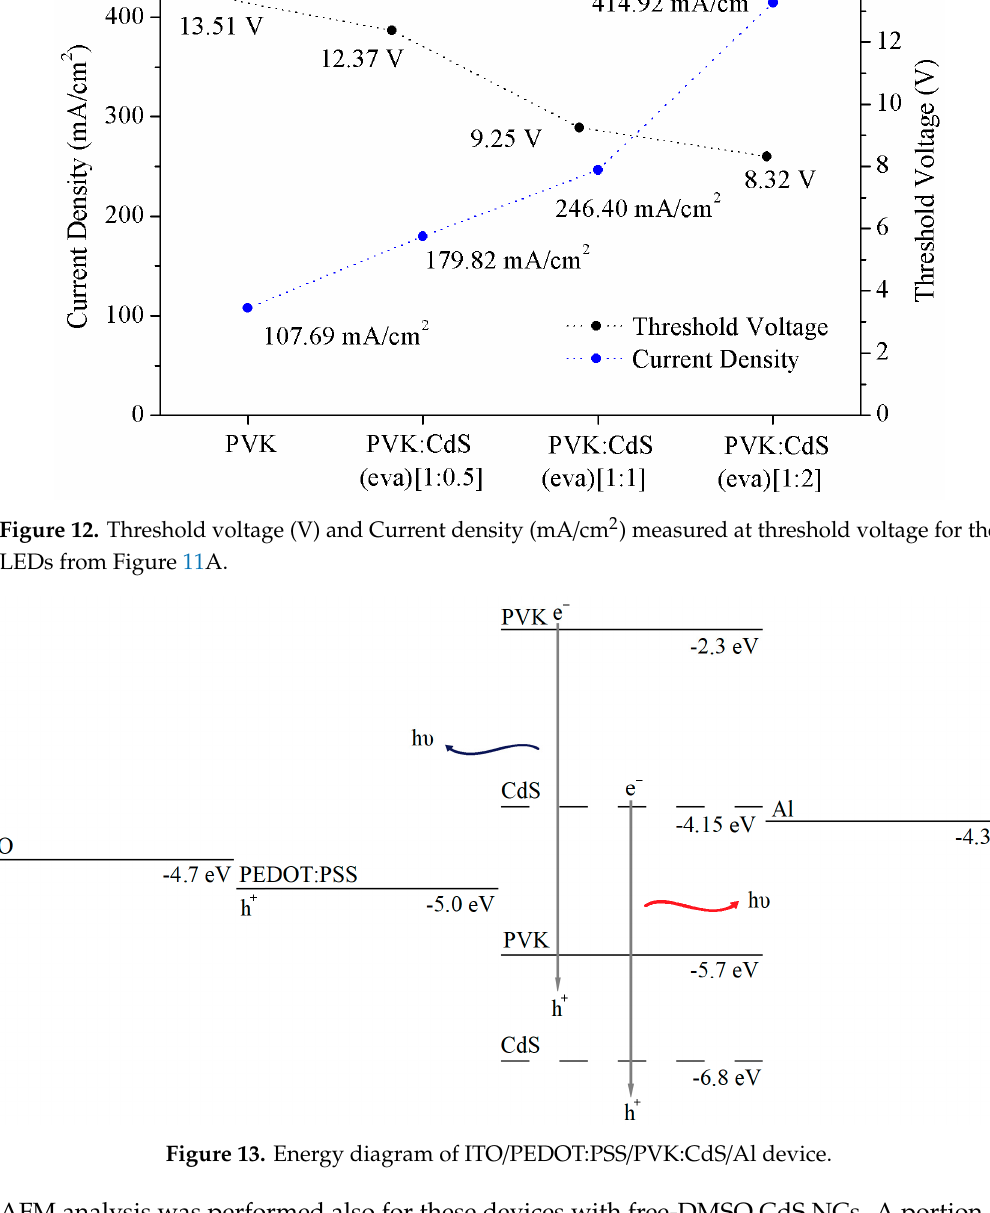
Figure 13. Energy diagram of ITO/PEDOT:PSS/PVK:CdS/Al device.